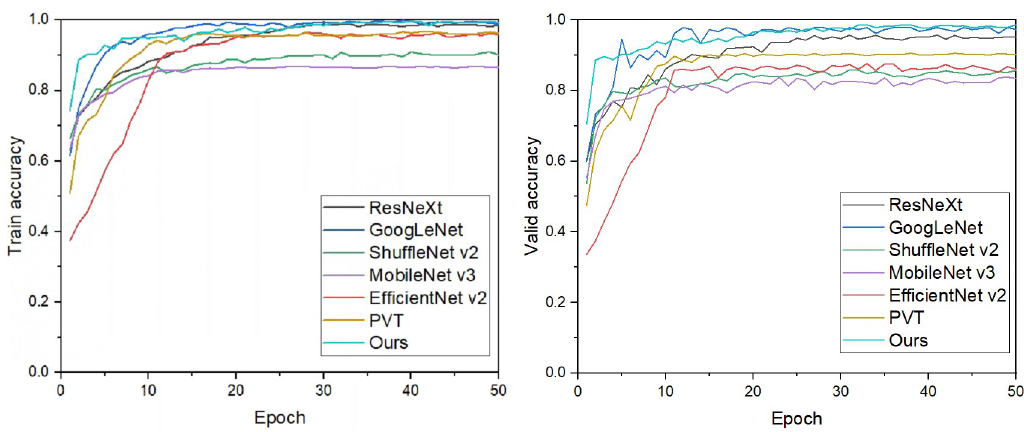
Fig 6. Comparison results of different network models: A is training accuracy of model, B is validation accuracy of model.